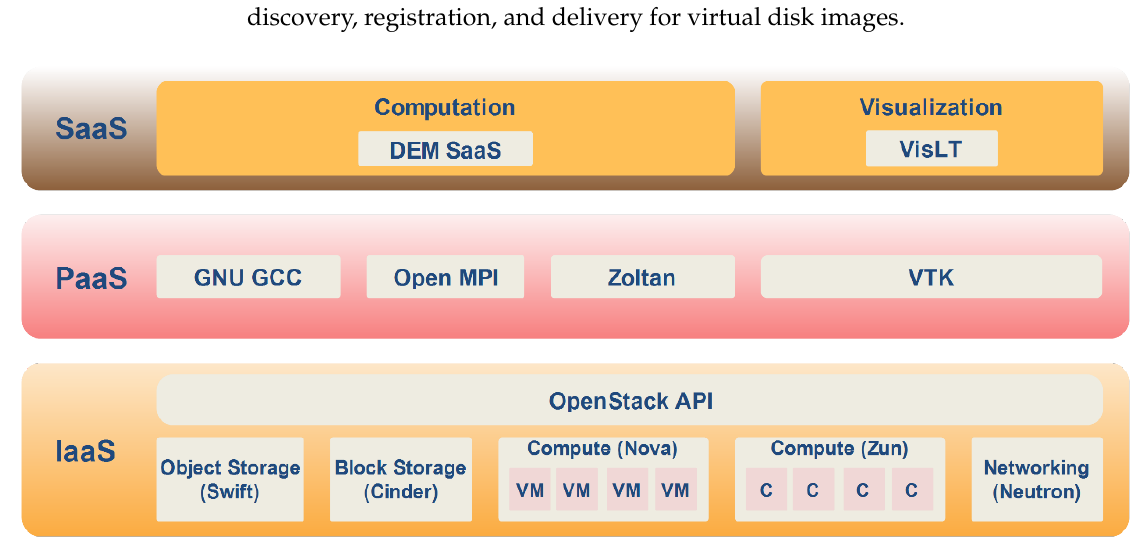
categories (Figure 1): Software as a Service (SaaS), Platform as a Service (PaaS), and Infra- structure as a Service (IaaS). Higher-level services for developers and users are deployed